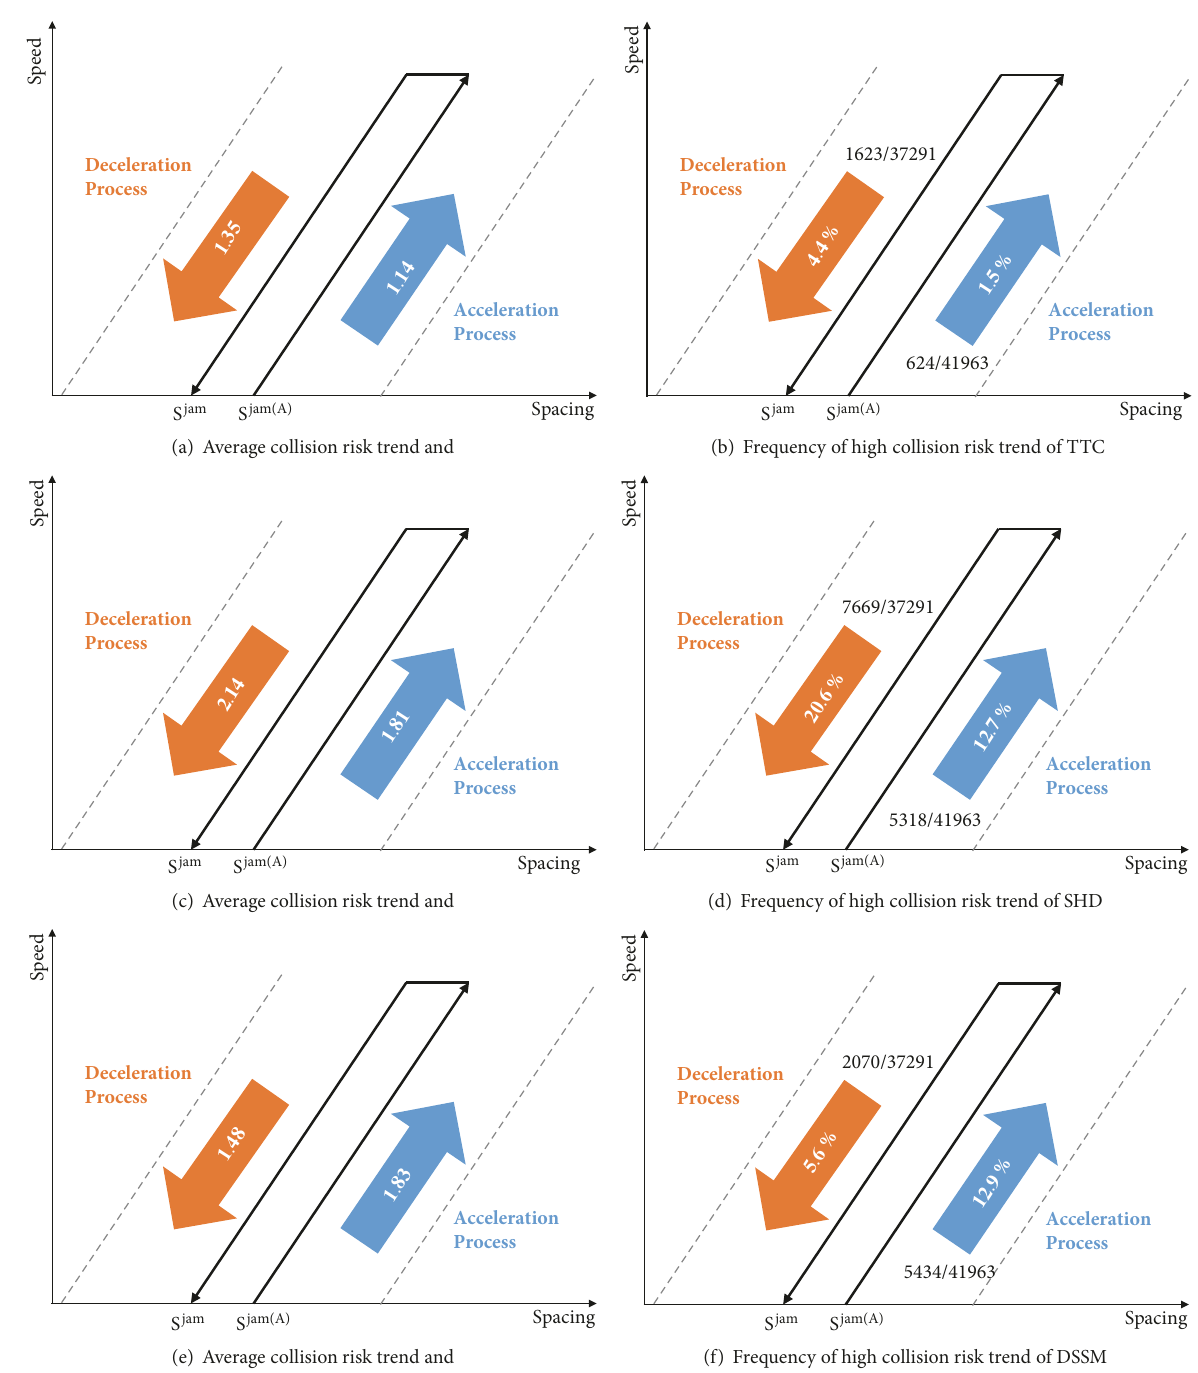
Figure 12: Each SSM trends on their average collision risks and frequencies of high collision